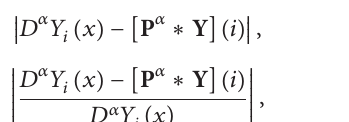
Table 1: Comparison of absolute error between SLOMFD